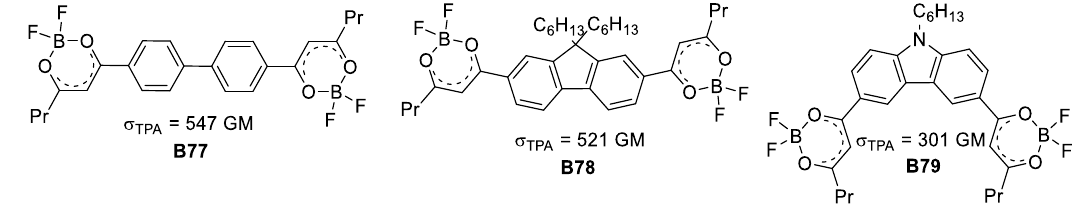
Figure 30. Series of compounds used for TPA-mediated photoreduction and deposition of silver.